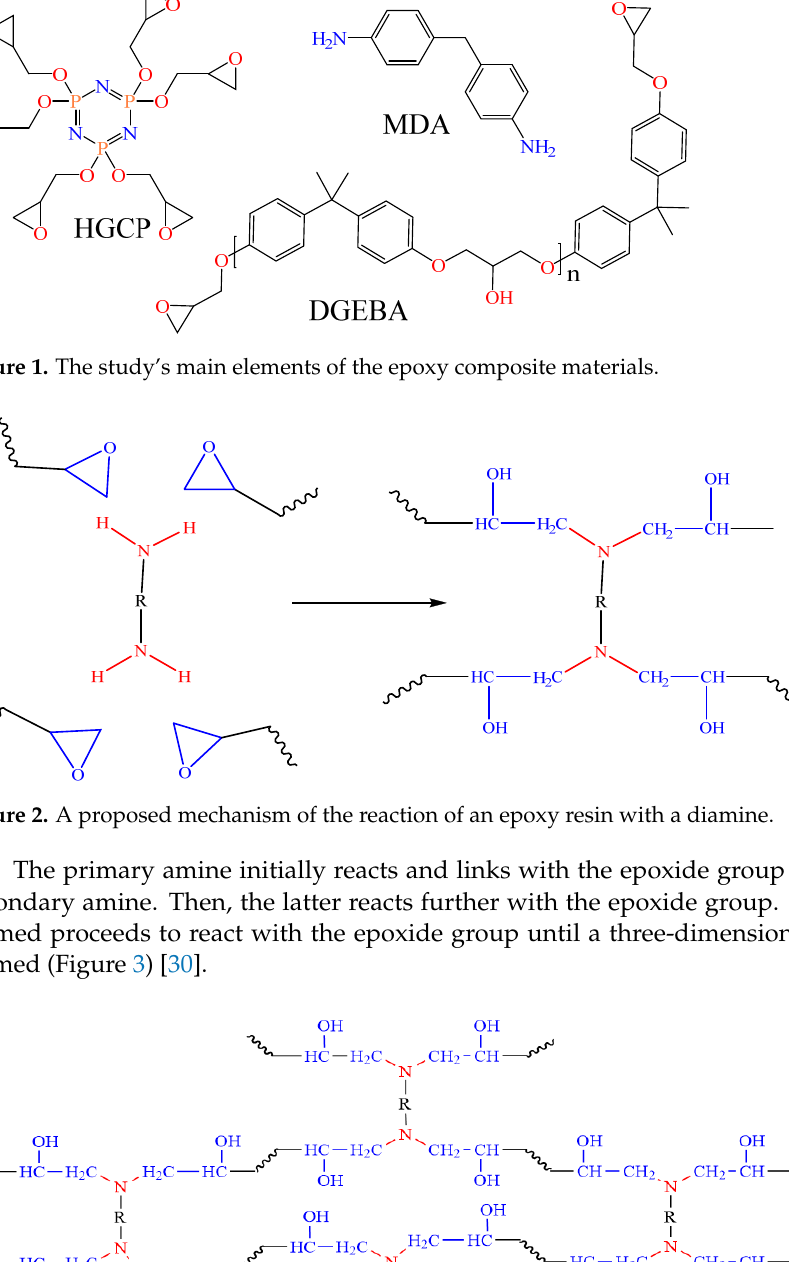
Figure 1. The study’s main elements of the epoxy composite materials.